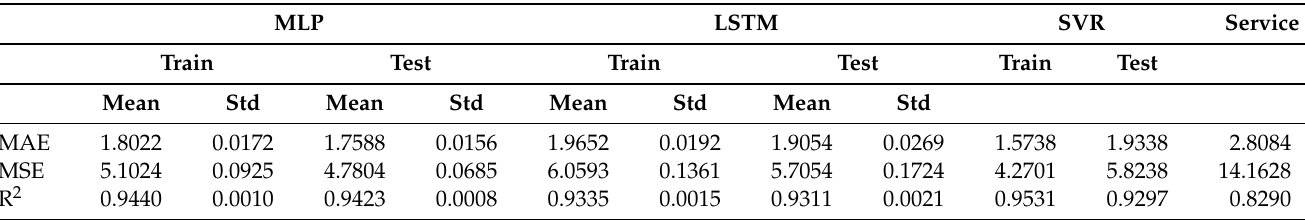
Table 10. Comparison of the effectiveness of the MLP model, two other models, and the weather service in forecasting the minimum temperature.